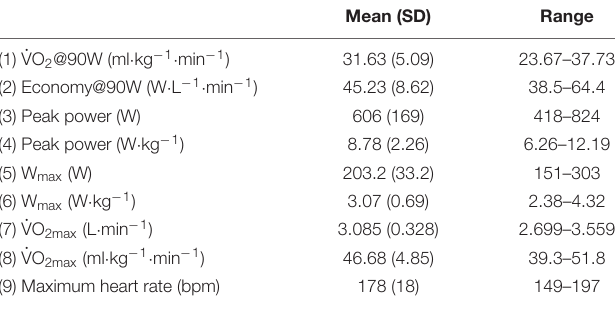
TABLE 1 | Mean ± SD and range for data taken from the submaximal (1–2)-maximal (3–9) component of testing. Mean (SD)